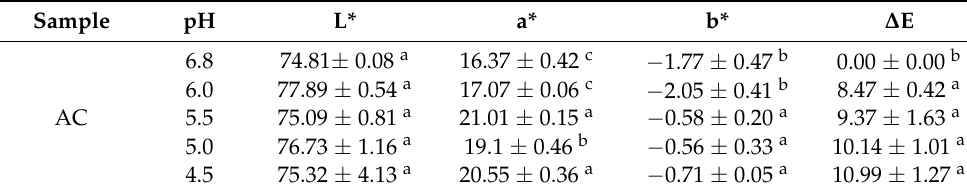
Figure 2. Photographs of the AC sensors with anthocyanins showing the colorimetric response to lactic acid at different pH levels. Table 2. Total color change values for the AC colorimetric